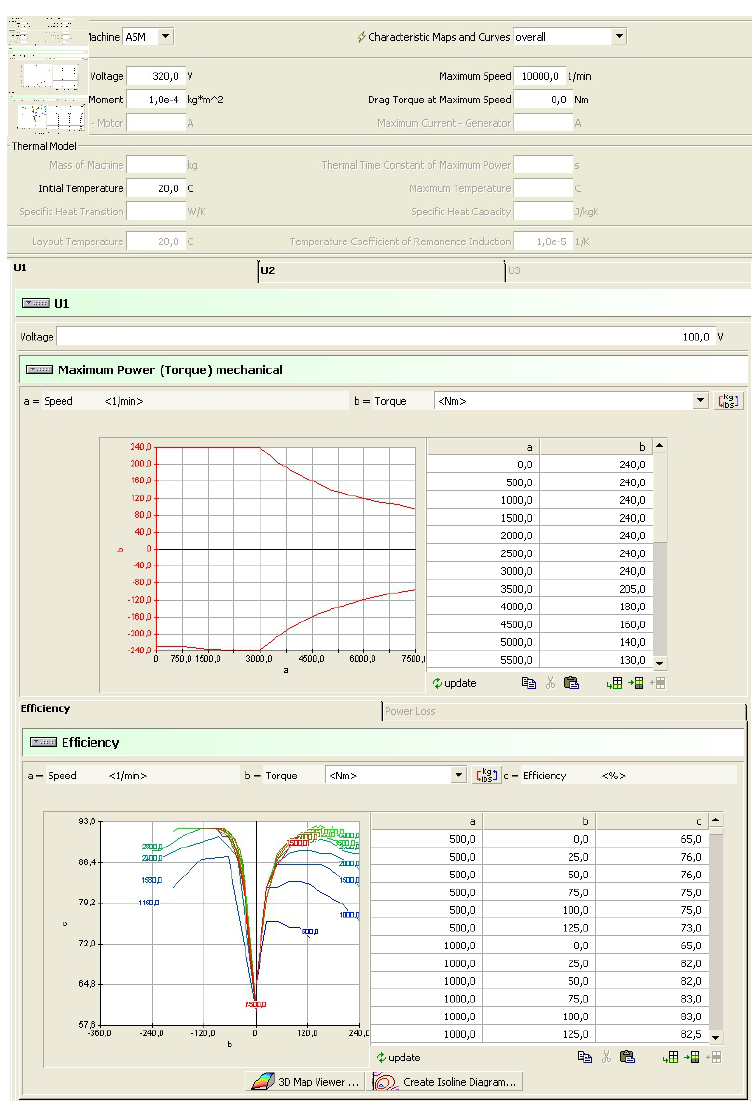
Figure 1. Database for establishing the physical characteristics of an electric vehicle’s